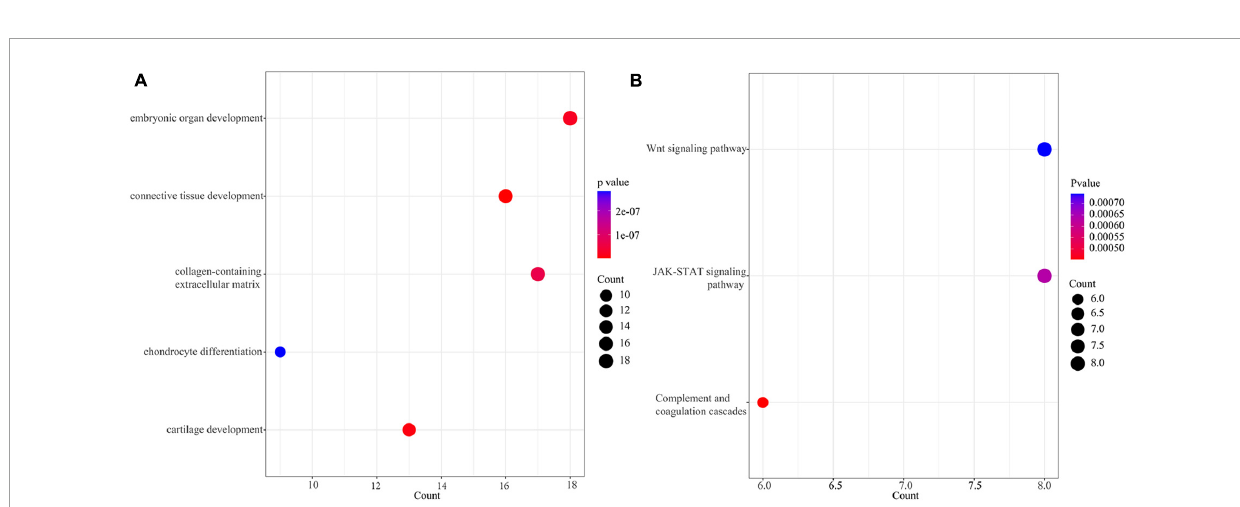
FIGURE2 Enrichment of methylation related genes (MRGs). (A) The top 5 terms (ordered from small to large by FDR) of GO enrichment analysis. (B) KEGG of